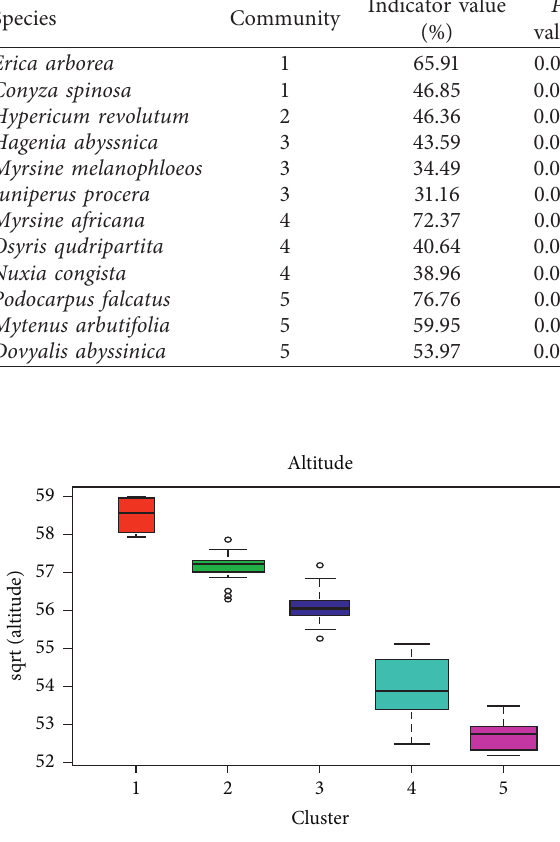
Figure 3: Boxplots of the association of plant community types with